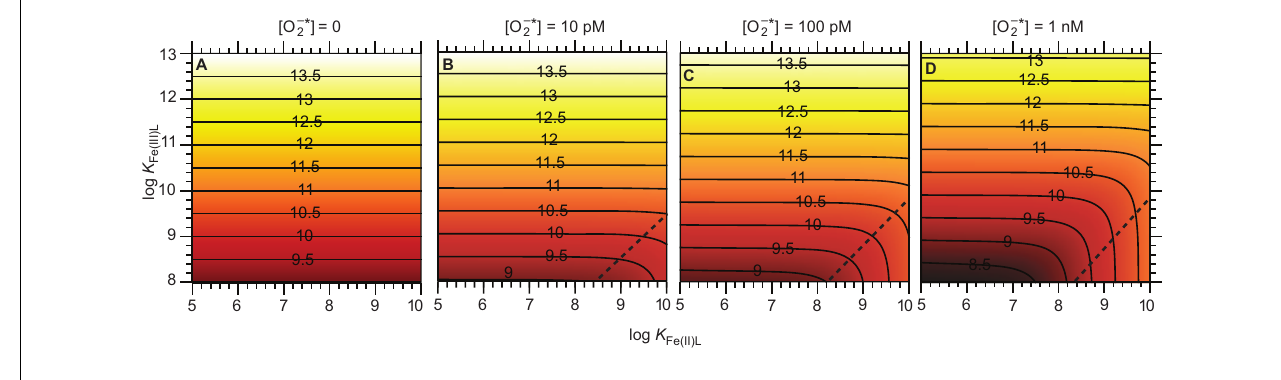
FIGURE 4 | Effect of O −∗ on Fe bioavailability in a system containing a constant pFe (cid:6) values, as indicated by the numbers marked on the contour 2 ] = 0. (B) Steady-state single Fe complexing ligand. (A) Steady-state [O −∗ lines.The region to the bottom right of the dashed lines in each panel 2 ] = 10 pM. (C) Steady-state [O −∗ ] = 100 pM. (D) Steady-state approximately indicates conditions where the strength of the Fe(II) complex [O −∗ 2 2 ] = 1 nM. Panels show the resulting pFe (cid:6) [ =− log[Fe (cid:6) ] =− log([Fe(II) (cid:6) ] + relative to that of the Fe(III) complex is sufficiently high that the presence of [O −∗ T 2 O −∗ [Fe(III) (cid:6) ]) at steady-state.The contours shown in each panel represent decreases Fe 2